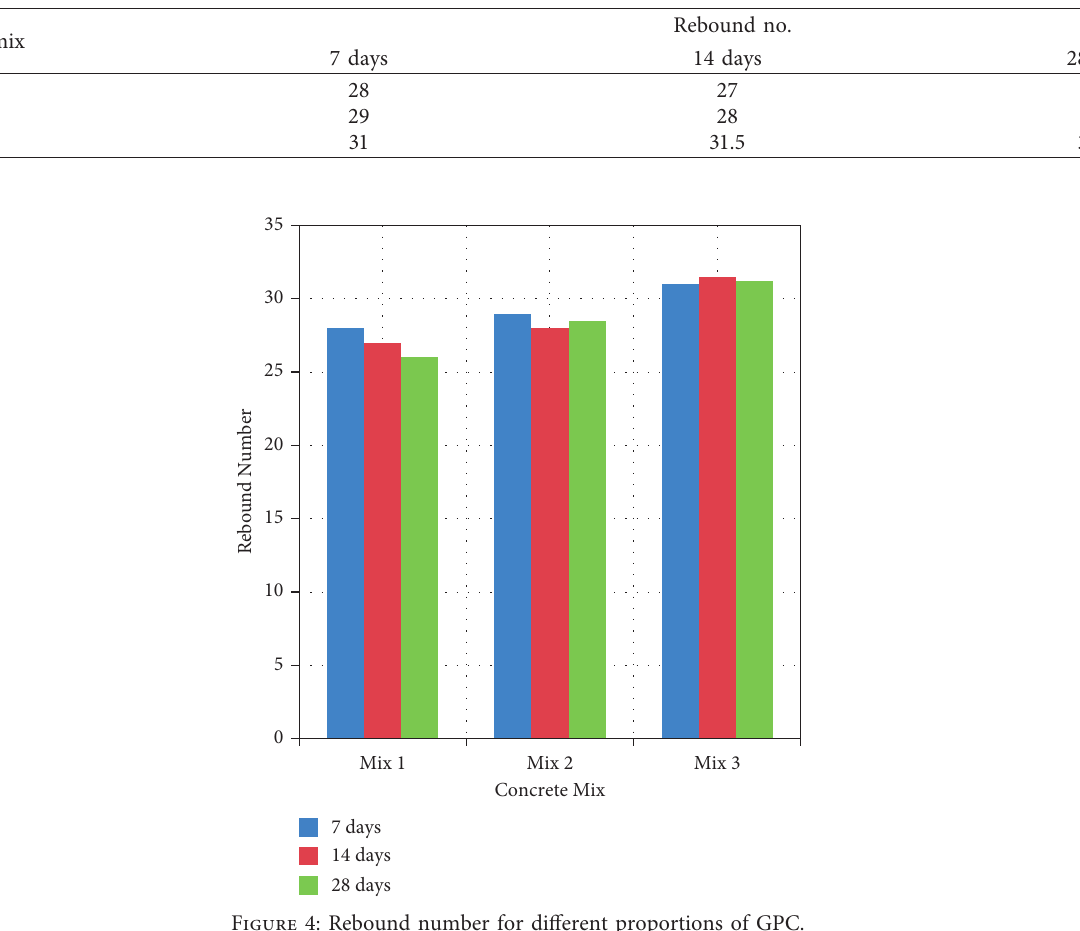
Figure 3: Rebound number for different proportions of OPC. Table 11: Rebound number for GPC.